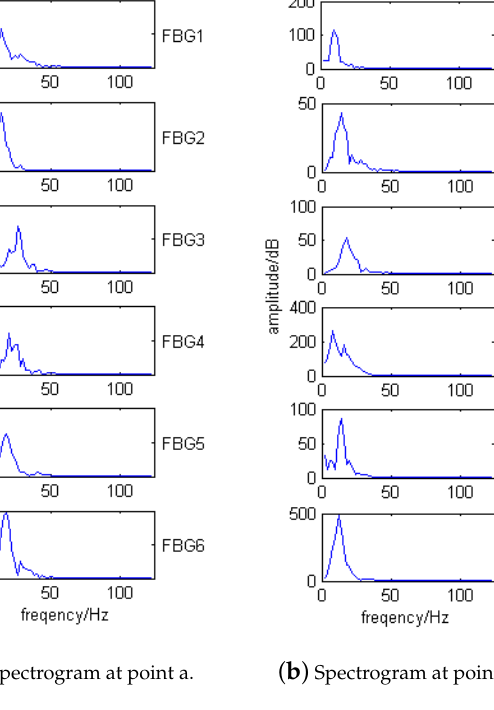
Figure 13. The third-order spectrum of the